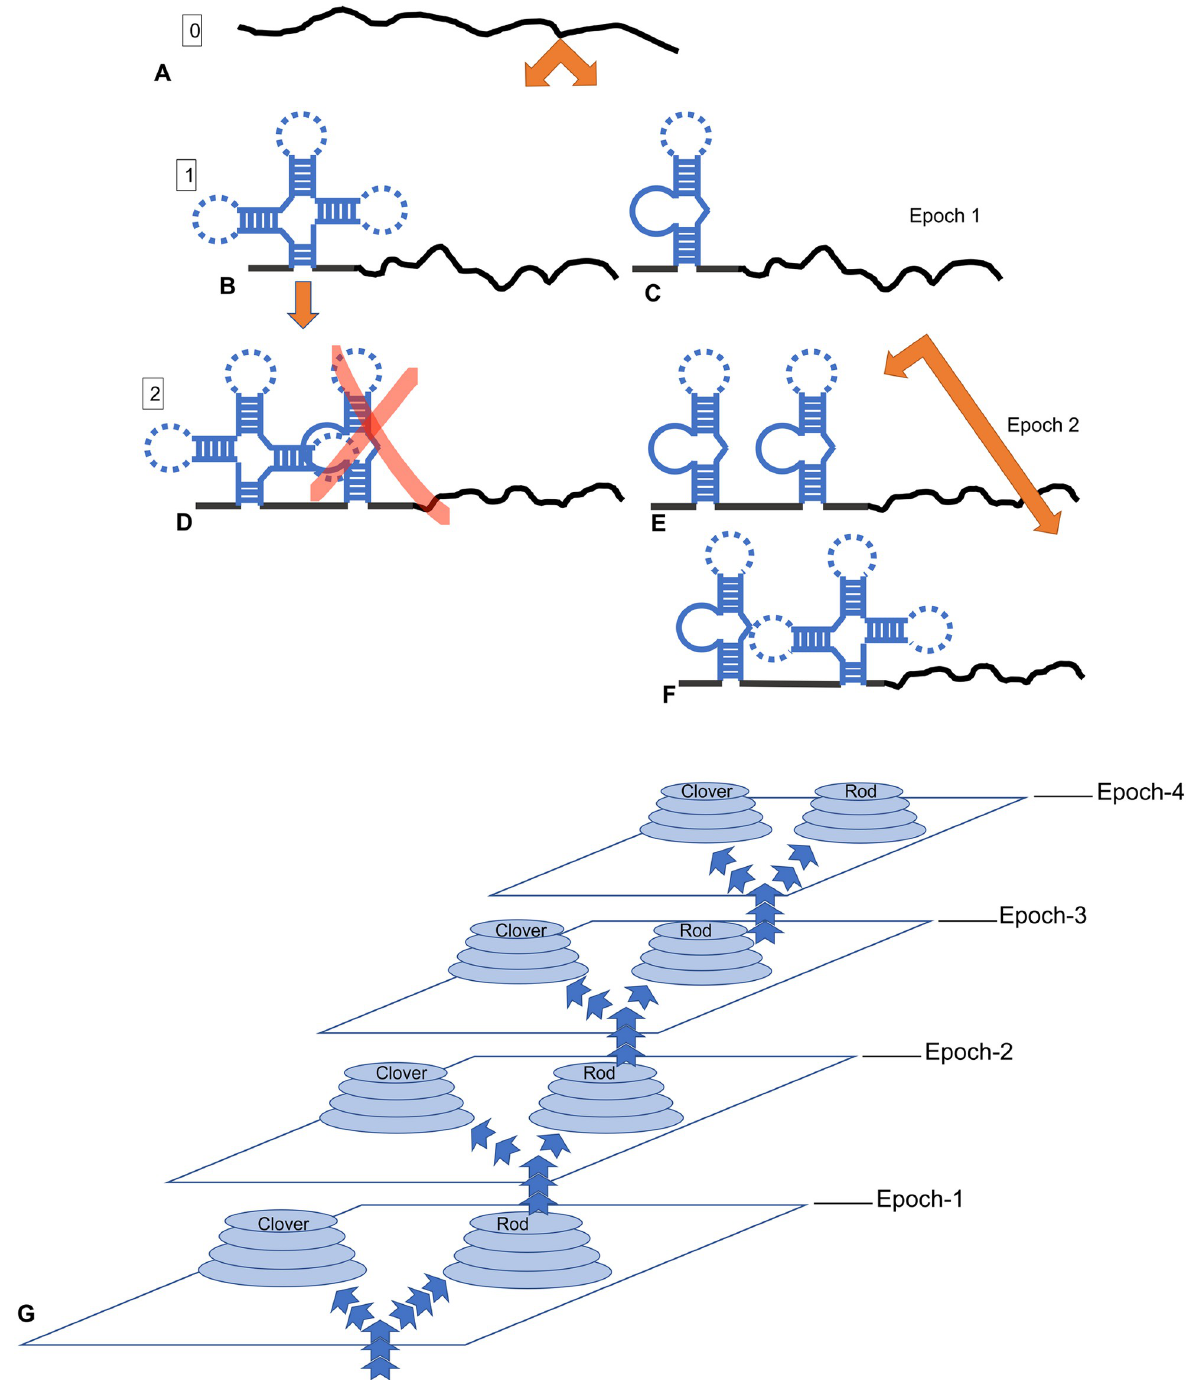
Fig 5. Extended (competitive) version of BioRS, implementing alternative aptamer structures and interference. (A-F) Evolutionary search scheme for the competitive BioRS. (A) An initial arbitrary sequence of a given length with zero fitness. (B-C) The first functional domain (aptamer) is identified by an evolutionary search. It may have one of two alternative structures: cloverleaf or rod (see Fig 4A). (D) If the cloverleaf structure is found in a certain position, this makes it impossible to find the second functional domain due to steric interactions of two neighboring domains. (E-F) In the case of a rod structure of the already found domain, it is possible to find the second functional domain in one of two alternative structures. This is only case (E) which can evolve further. (G) Schematic of the competitive BioRS illustrating its multimodality (bimodality within each epoch). See text for